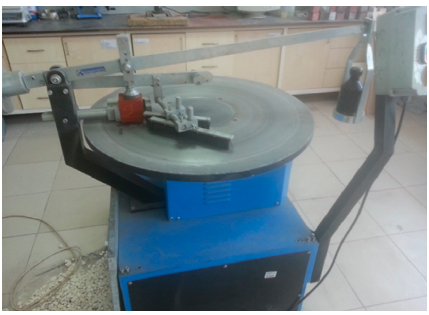
Figure 2: Bohme abrasion test apparatus.